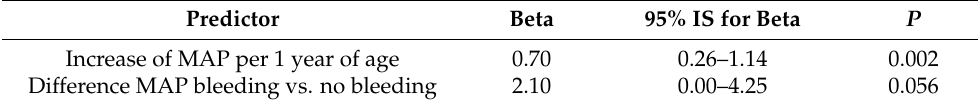
Table 3. Linear regression model.